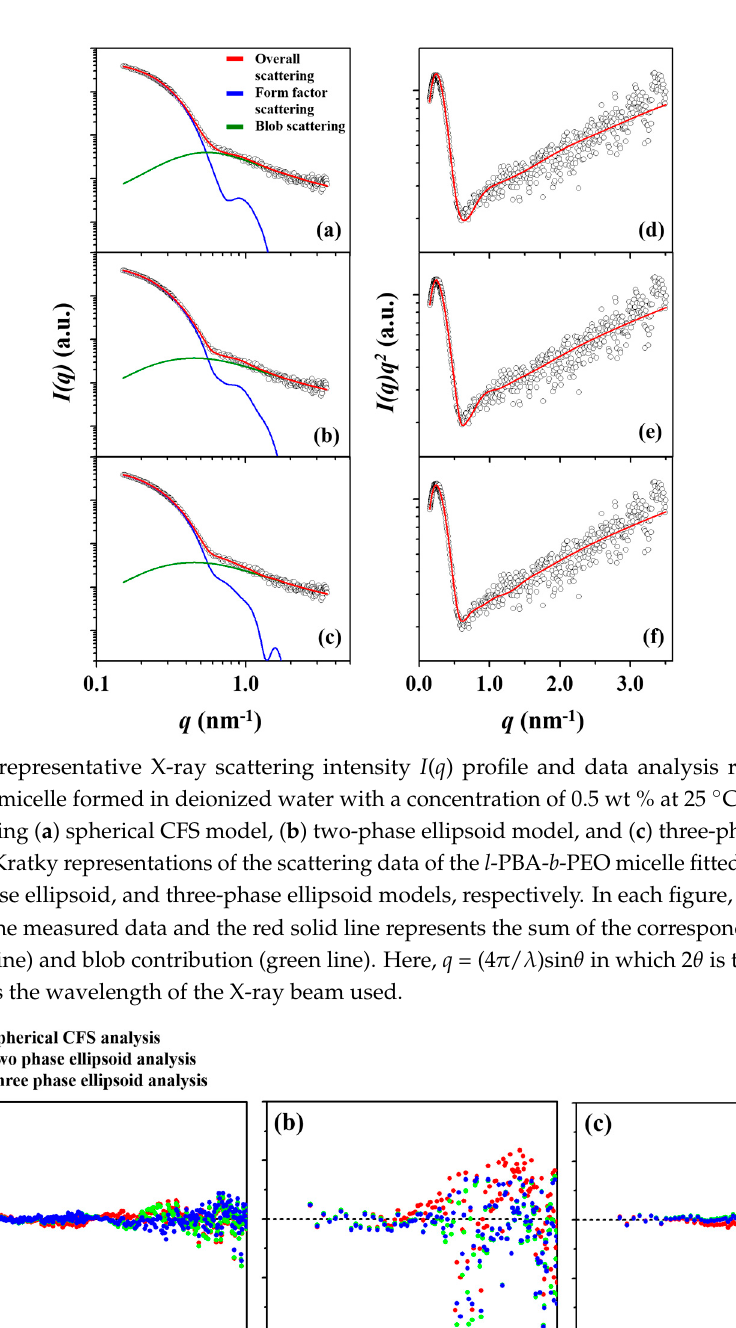
Figure 3. Deviation between the measured scattering data and the data analysis results obtained by various analysis schemes over the q -range of 0.15 to 1.5 nm − 1 : ( a ) l -PBA- b -PEO micelle; ( b ) l -PBA- b -PEO- b - PBA micelle; ( c ) c -PBA- b -PEO micelle. Each value of deviation was calculated by the following formula [( I obs − I calc )/ I obs ] × 100% where I obs is the measured scattering intensity and I calc is calculated scattering intensity from data analysis. The colored circles represent the deviations from results of spherical CFS (red circles), two-phase ellipsoid (green circles), and three-phase ellipsoid (blue circles) models. The deviations in q -range of 1.5 to 3.5 nm − 1 are not shown due to the insignificantly large deviations arising from the high levels of noise in the raw scattering data in high- q